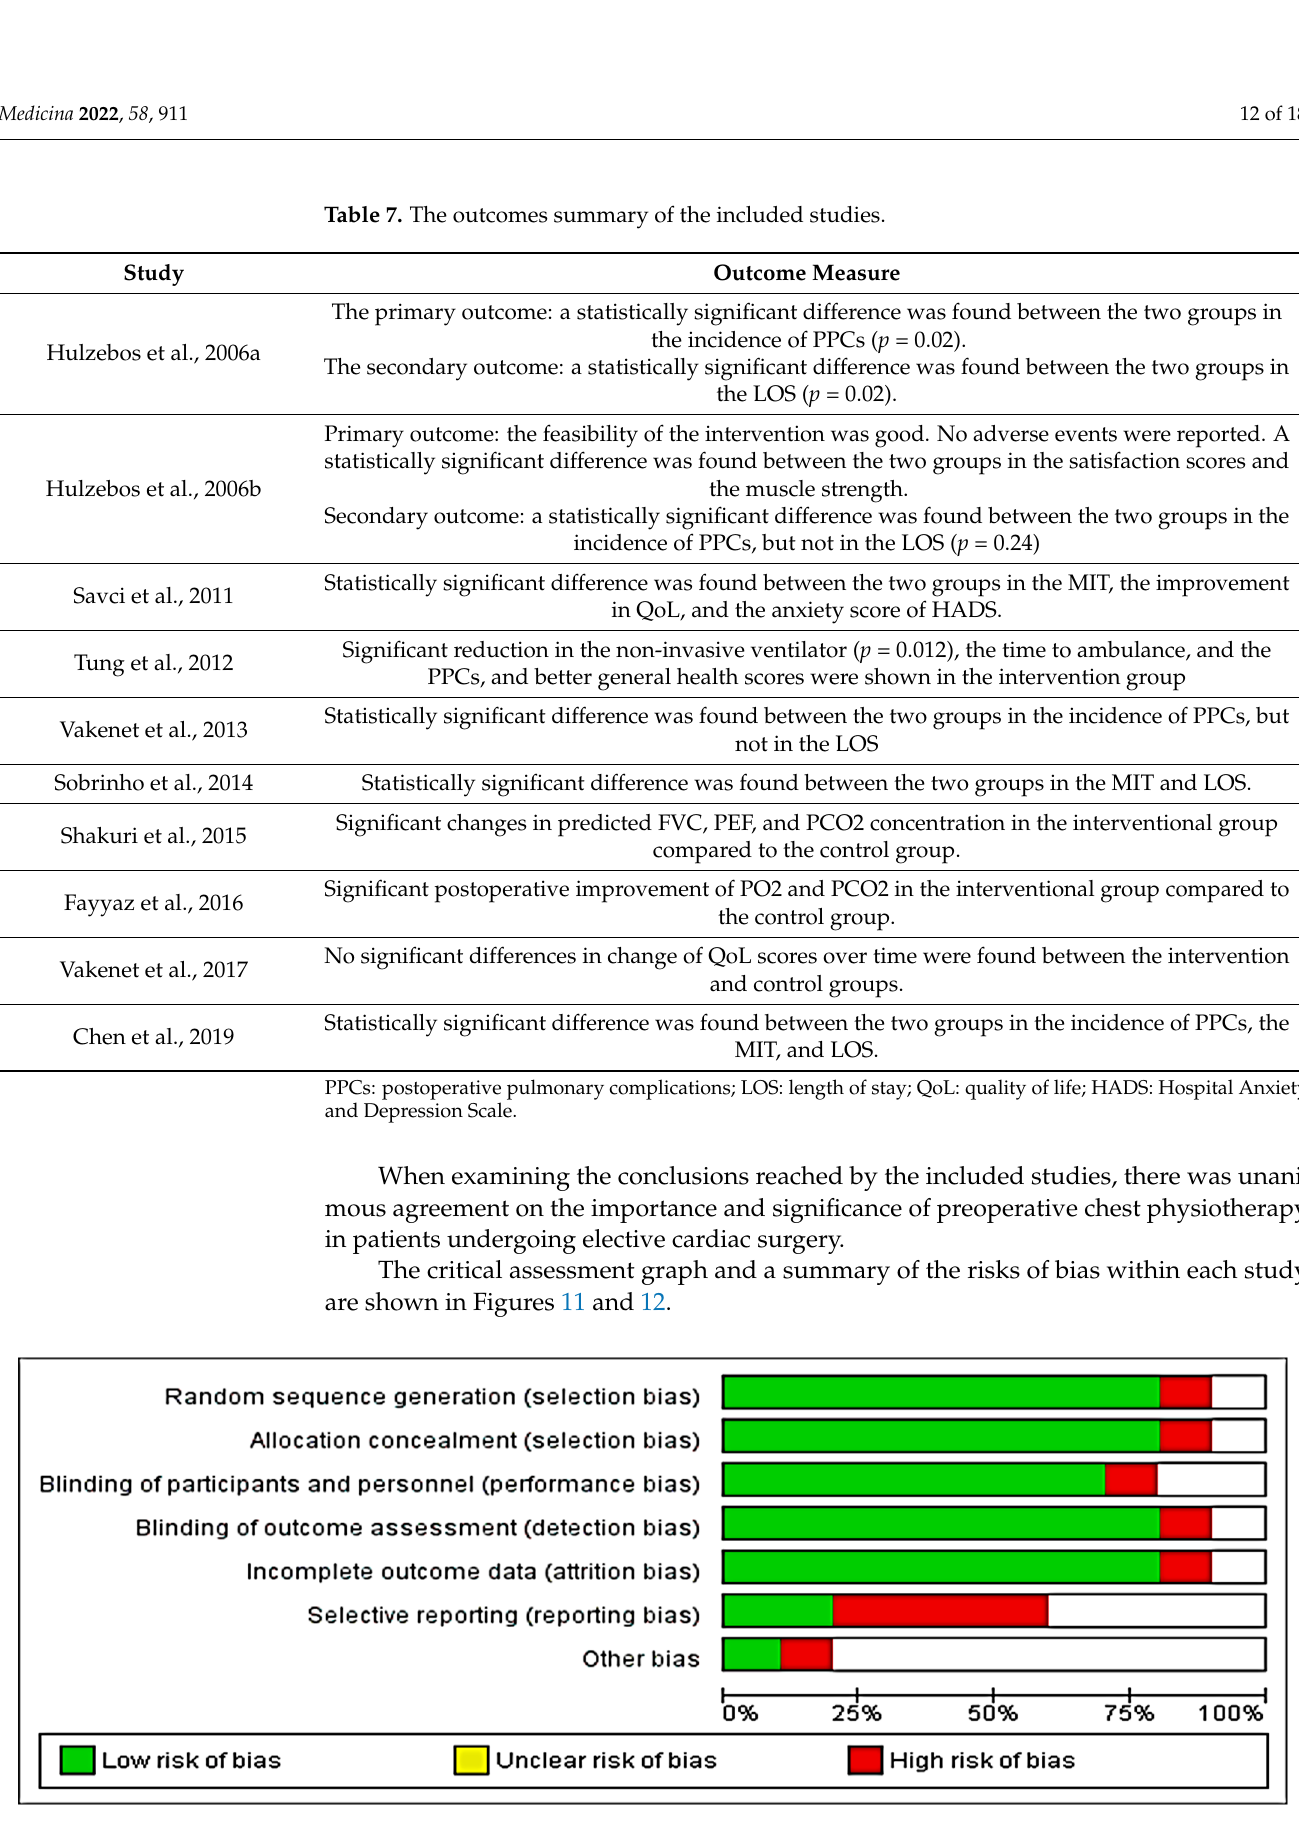
Figure 11. Risk of bias graph for the included studies.